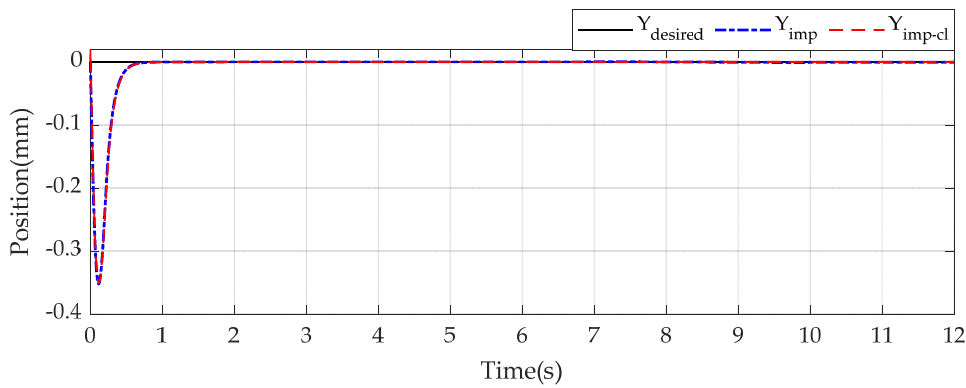
Figure 7. Position tracking e ff ort along the Y-direction.